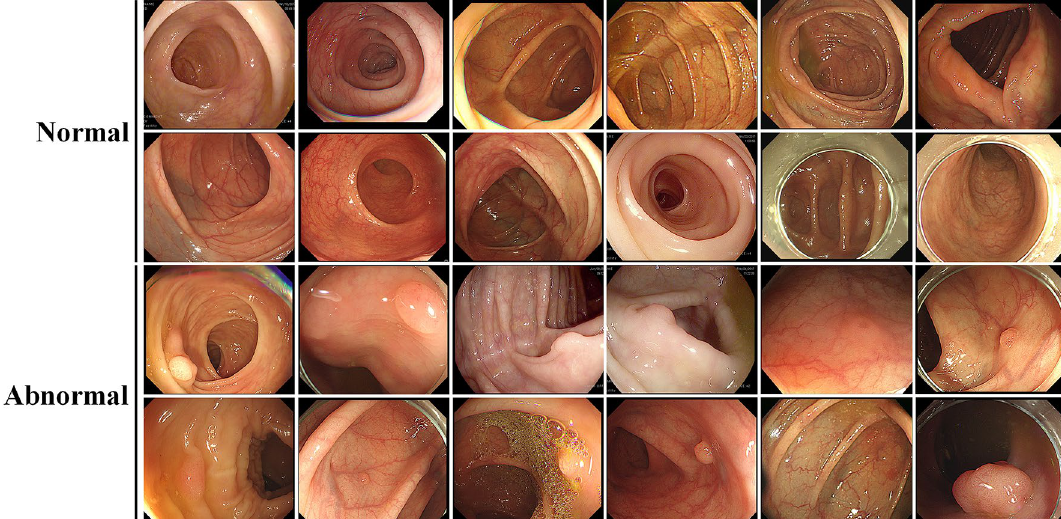
Figure 1. Samples of colonocopy images used in the